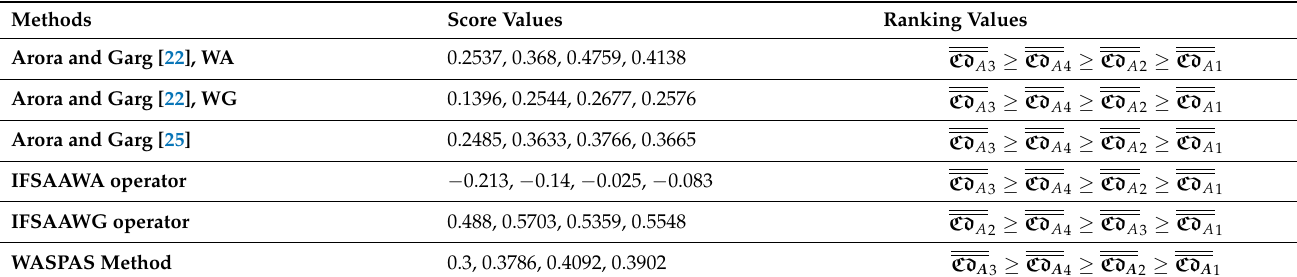
Table 9. Comparative analysis for IFS